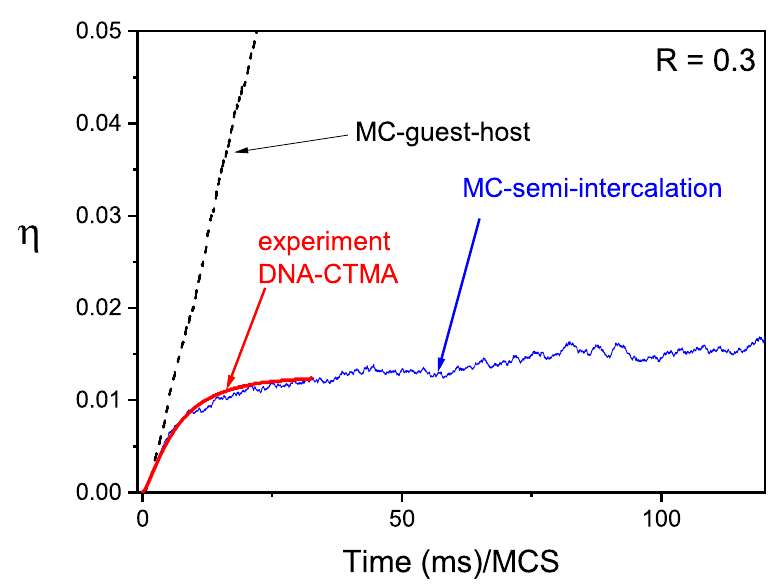
Figure 22. The kinetics of grating inscription, characterized by scaled diffraction efficiency η = ∆ 2 , in DNA-CTMA-DR1 experiment and in MC semi-intercalation and host-guest